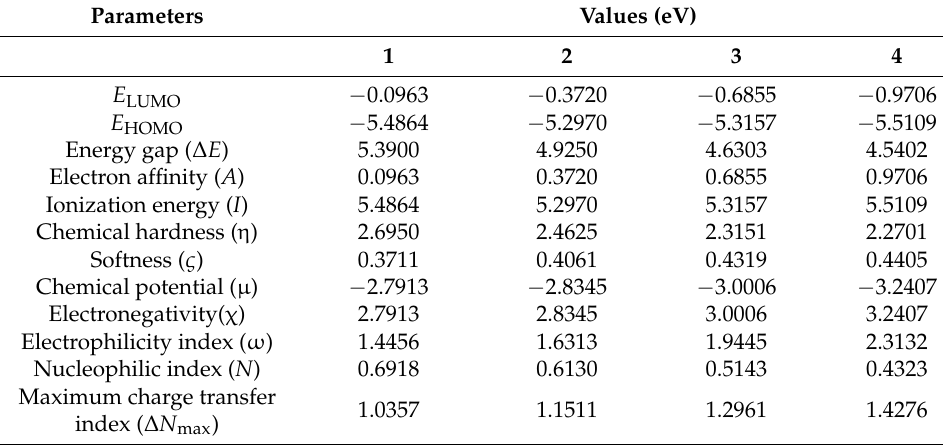
Table 3. Electronic properties of the molecules under